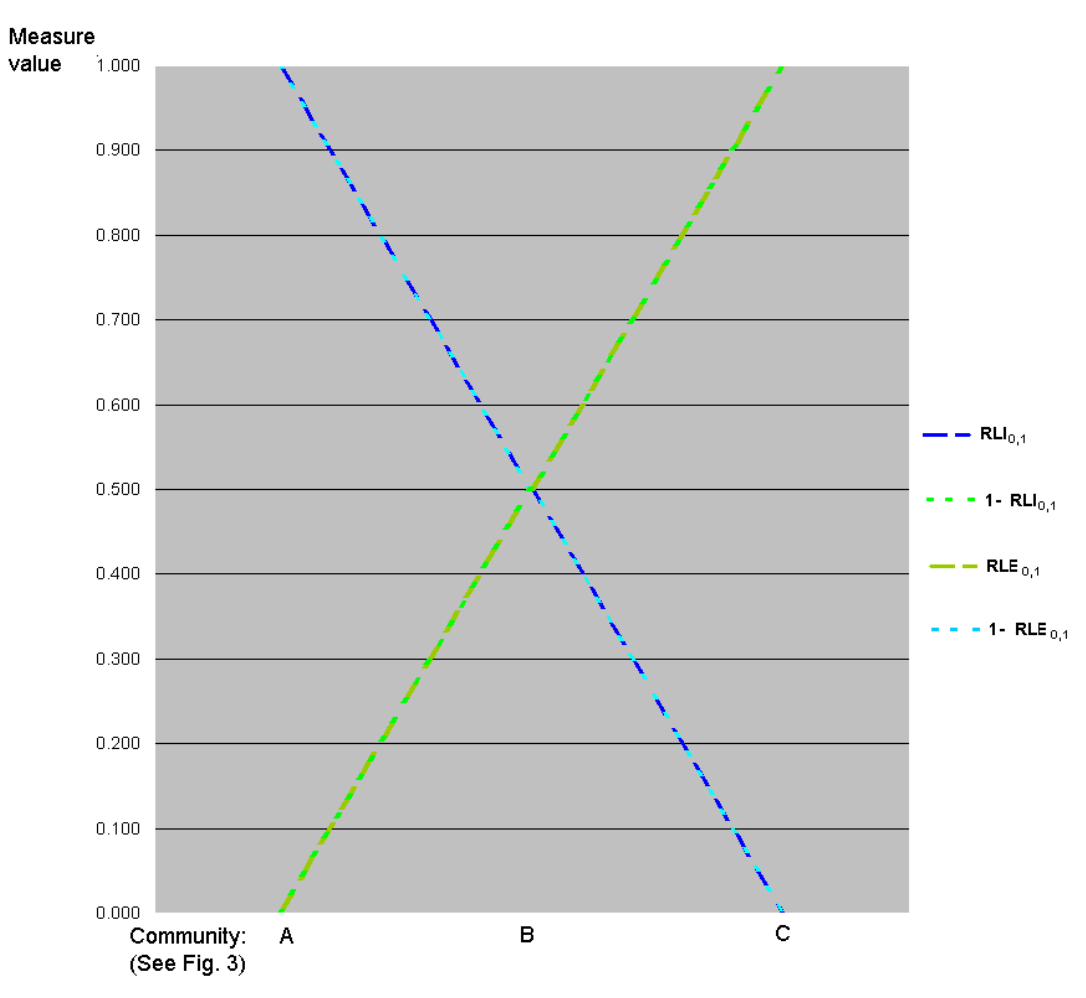
Figure 5. Complementarity of relative logarithmic evenness RLE logarithmic inequality RLI Community B, and Community C from Figure 3. This shows that RLI complements of each other. Compare Figure